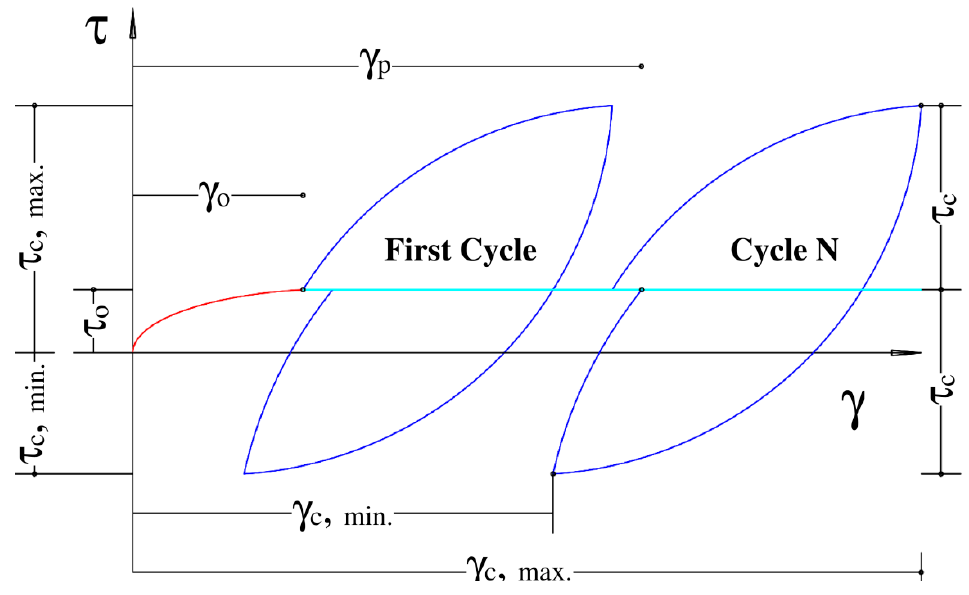
Figure 8. Stress-strain definitions.